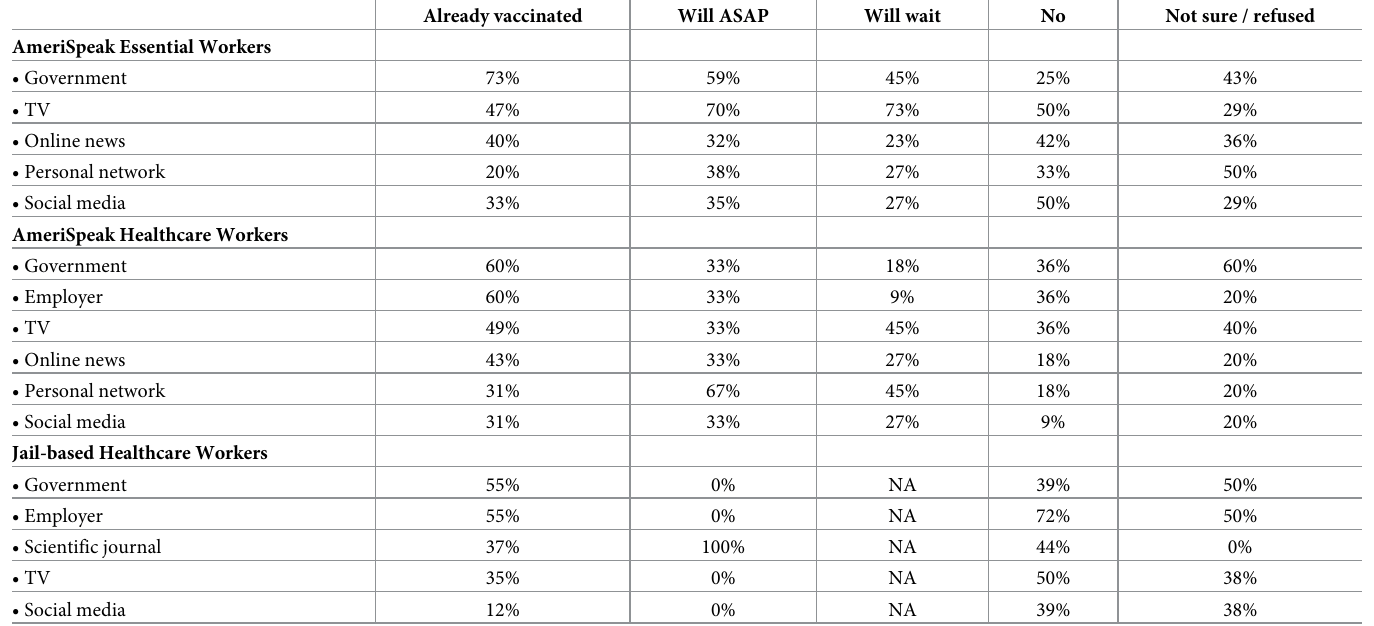
Table 2. Sources of COVID-19 information.